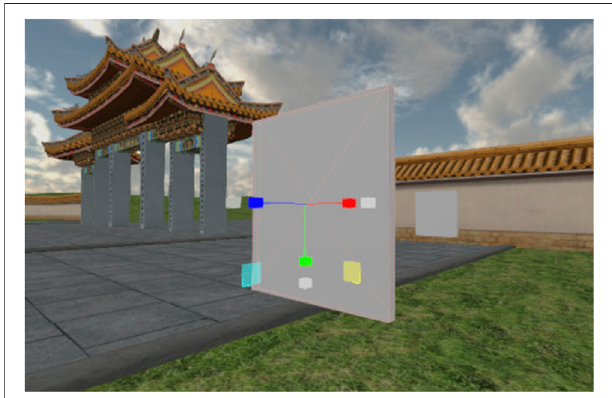
FIGURE 1 | An example of a gizmo transformation tool in JanusWeb.